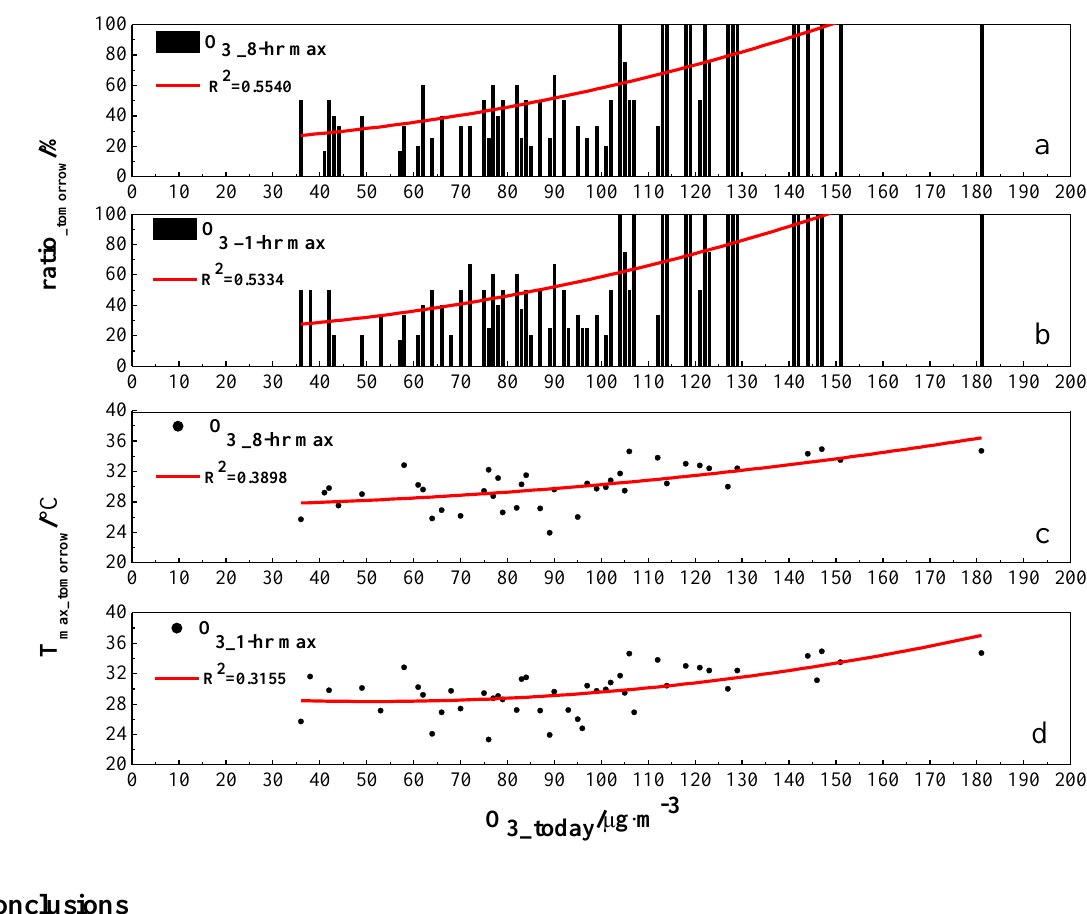
Figure 8. The corresponding exceed-standard ratios at the following day of ( a ) O and ( b ) O _ on the current day, and the corresponding max temperature on 3 1-h max the current day when ( c ) O _ , and ( d ) O _ exceed the standard at the 3 8-h max 3 1-h max following